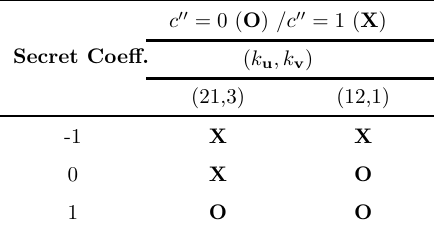
Table 1: Unique distinguishability of every key candidate based on the validity of the codeword for the chosen values of ( k u , k v ) for our attack on the R5ND _ 1KEM _ 5d variant of IND-CCA secure Round5 KEM. O and X refer to valid ( c 00 = 0) and invalid codewords ( c 00 = 1)